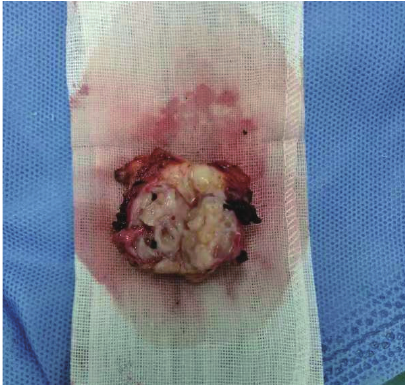
Figure 3 Macroscopic examination of the ablated tissue revealed an indented friable and soft mass inside several cysts.